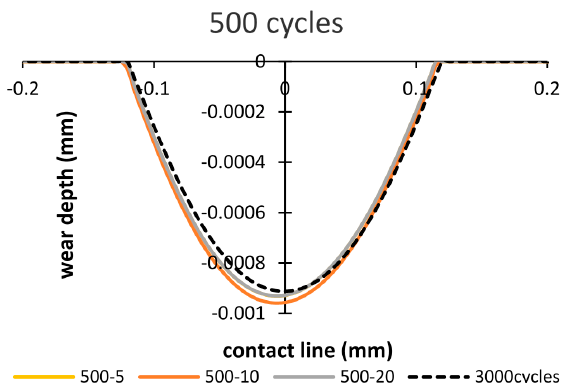
Figure 13. Wear scar after 3000 cycles of the debris layer model: importing time = 500 cycles and layer thickness = 5 µm, 10 µm, 20 µm.